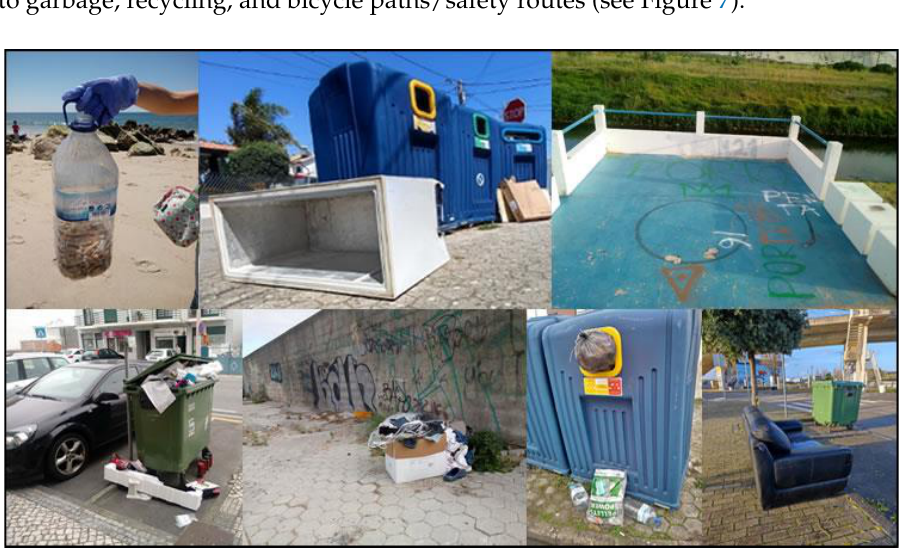
Figure 7. Garbage, recycling, and other issues in the local